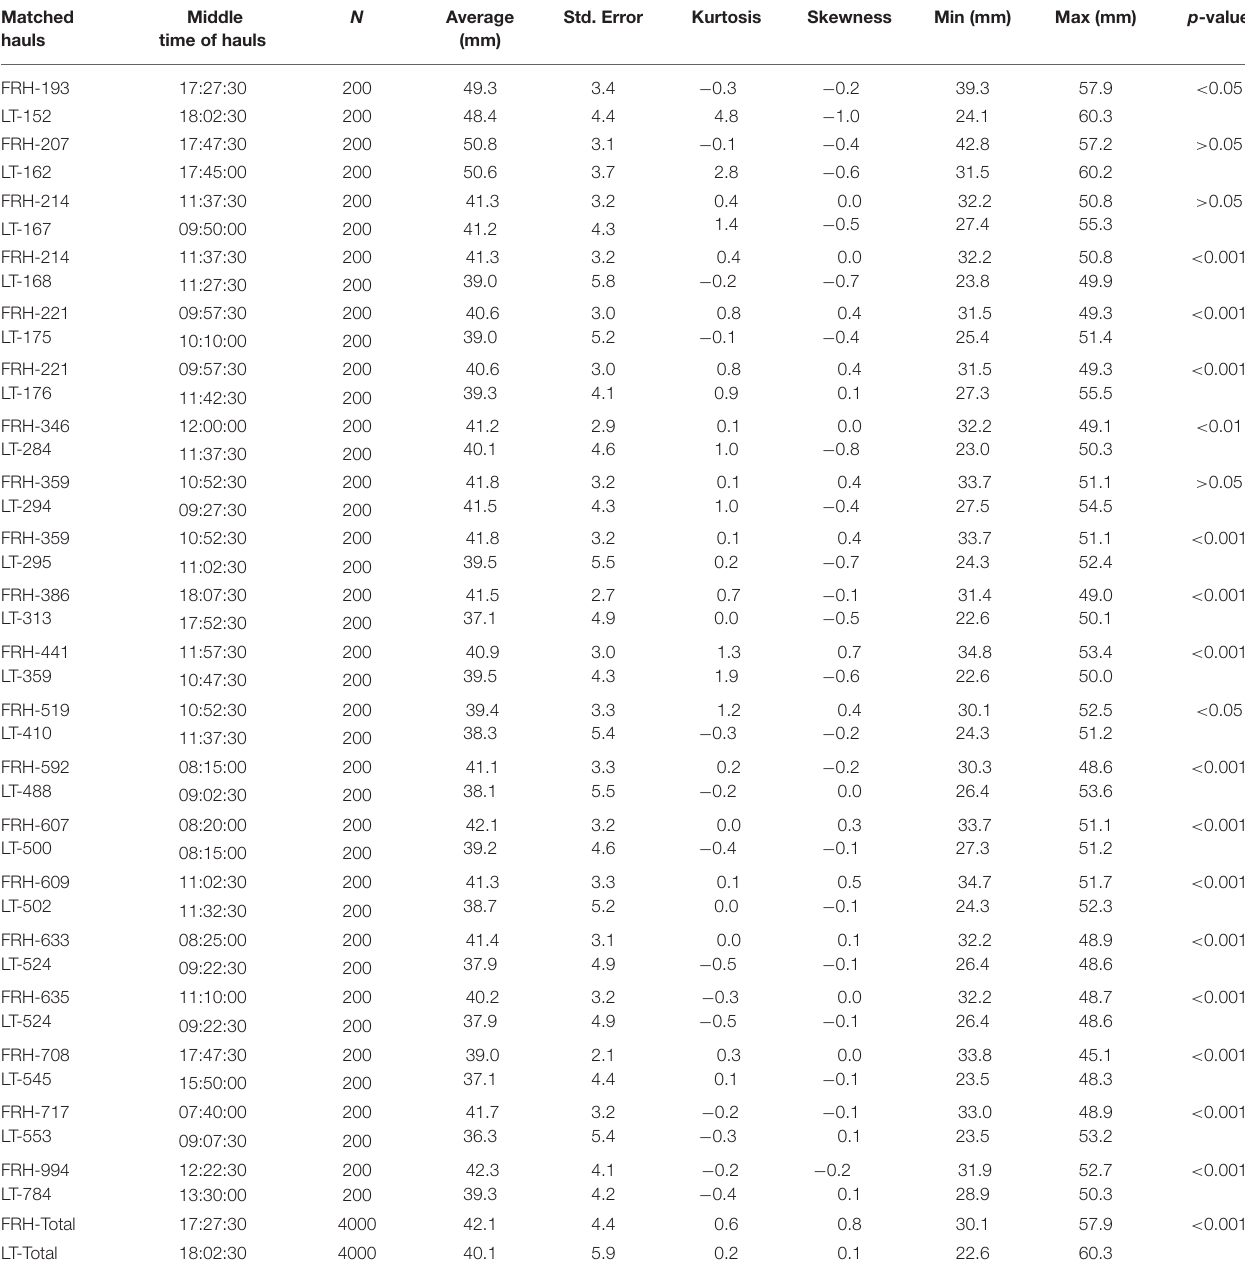
TABLE 2 | Length composition of krill in catches of both trawls and differences of matched hauls. Matched Middle hauls time of